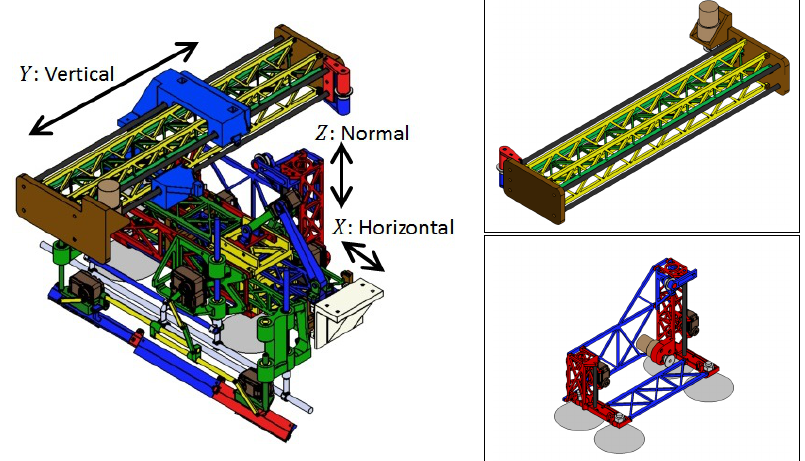
Figure 5. The CAD design of the module ( Left ). The modules have the basic structure of three linear actuators, which are equipped like X – Y – Z stage and adhere to the glass surface via suction cups. For the linear actuators in both normal and vertical direction, a ladder chain and sprocket mechanism is adopted ( Right ).